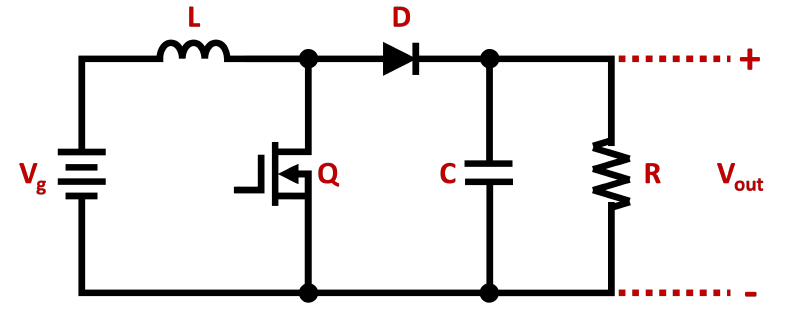
Figure 5. Basic topology of a buck converter.